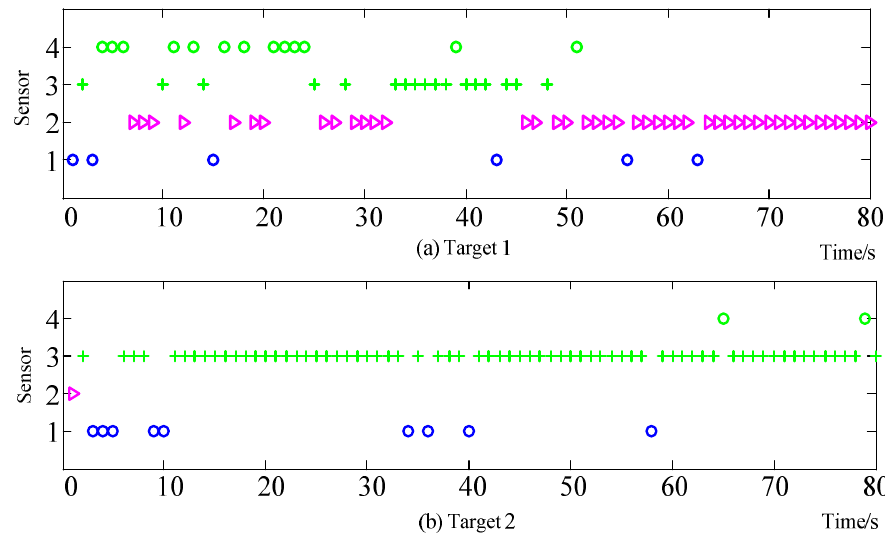
Figure 19. Sensor selected sequences obtained by BDSP. ( a ) Target 1; ( b ) Target Figure 19 . Sensor selected sequences obtained by BDSP. ( a ) Target 1; ( b ) Target 2.